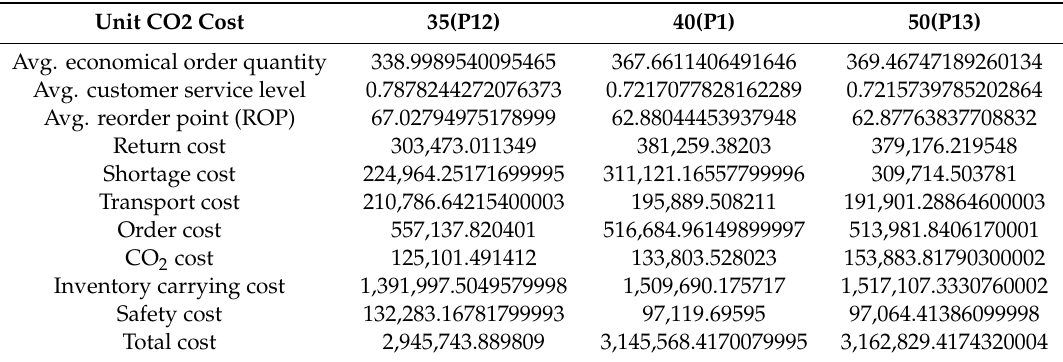
Table 19. The results of the sensitivity analysis for unit CO 2 cost based on ROPIRPSDRCO 2